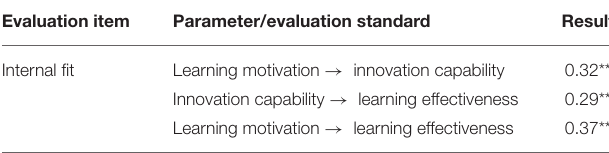
TABLE 1 | Overall linear structural model analysis